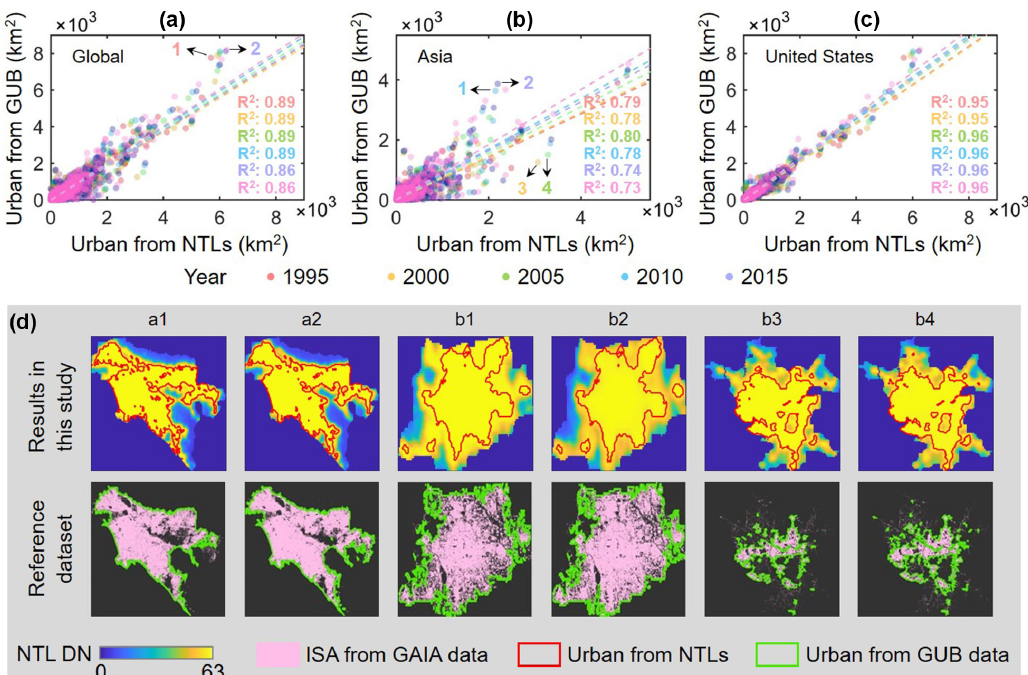
Figure 8. Comparisons of spatial extents between NTL- and GUB-derived urban areas. (a–c) Comparisons of the total area of the urban extent for each urban cluster in different periods globally, in Asia, and in the United States, respectively. (d) A comparison of the urban spatial extent within the marked clusters (see a and b ) in different years. a1 and a2 are comparisons in the Los Angeles-dominated urban cluster in 1995 and 2015, respectively. b1 and b2 are comparisons in the Beijing-dominated urban cluster in 2010 and 2015, respectively. b3 and b4 are comparisons in the Incheon–Seoul-dominated urban cluster in 2000 and 2005, respectively.